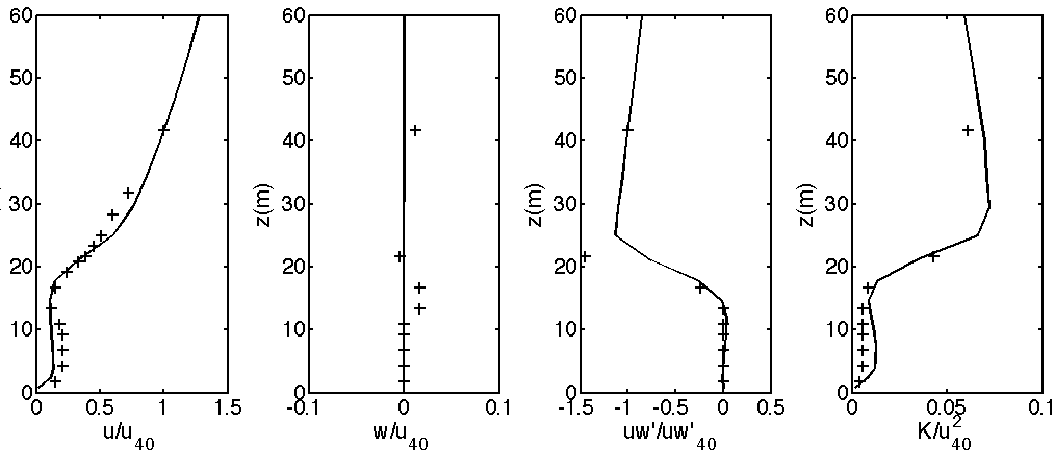
Figure A2. Simulated wind statistics over canopy Can1 with PGF4 (lines), against experimental data ( + ’s): ( a ) u -velocity profile; ( b ) w -velocity profile; ( c ) momentum flux; ( d ) turbulent kinetic energy.